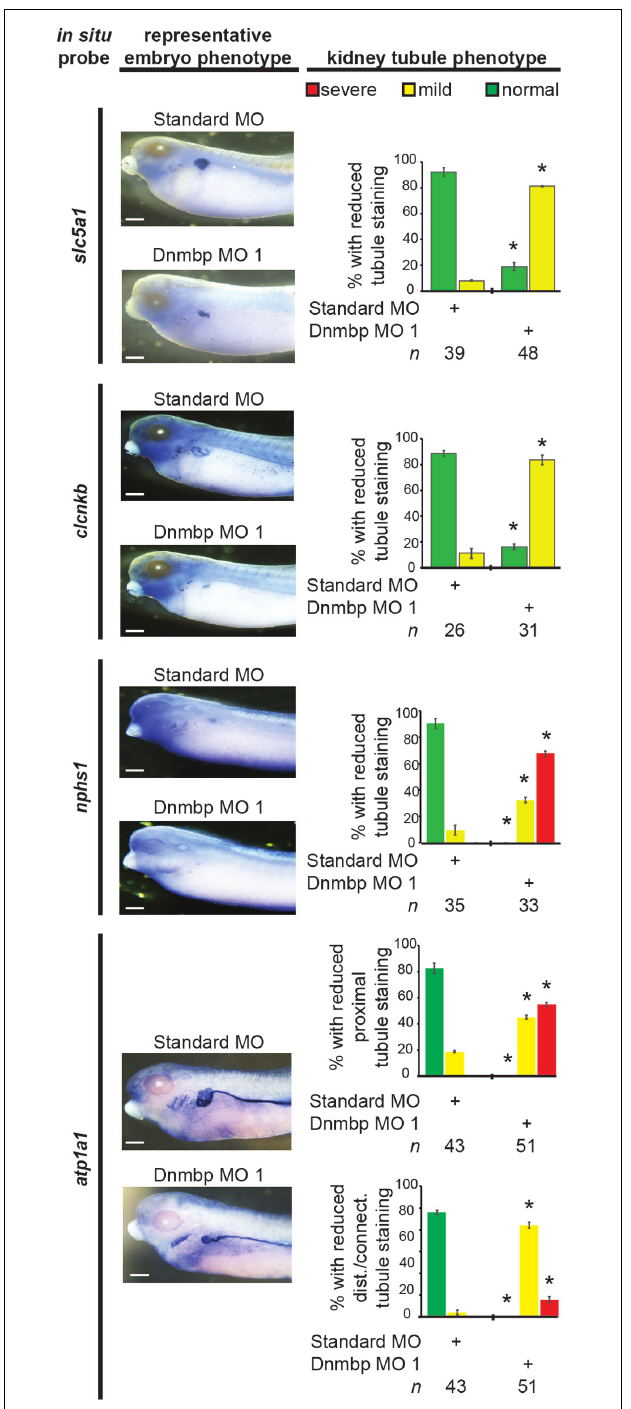
FIGURE 10 | Dnmbp knockdown alters expression of late markers of kidney development, as assessed by in situ analysis. Embryos injected unilaterally at the 8-cell stage (blastomere V2) to target the kidney and reared to stage 40–41 for slc5a1 , clcnkb, and atp1a1 expression assessment or stage 36–37 for nphs1 expression assessment. Representative embryo phenotypes shown. Scale bar indicates 500 µ m. n = number of embryos across 2 ( slc5a1 , clcnkb , nphs1 ) or 3 replications ( atp1a1 ). Error bars represent Standard error. ∗ Significantly different from control, p < 0.05.